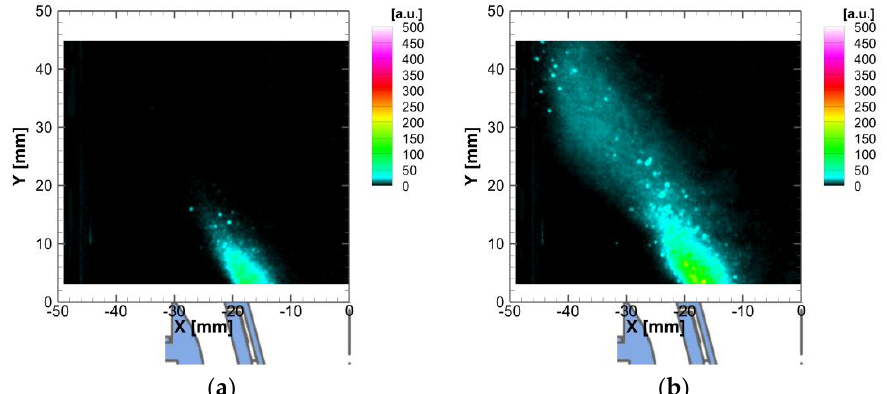
Figure 11. Distributions of Mie-scattering under idle conditions: ( a ) case P and ( b ) case M. (Illustration of the burner exit section is superimposed beneath the horizontal axis).